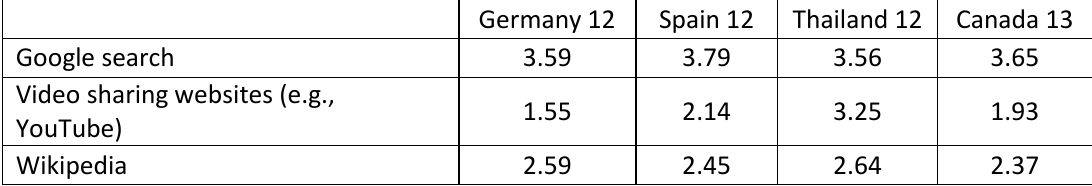
Table 14 . Students’ answers to the question: How often do you use the following for learning/study